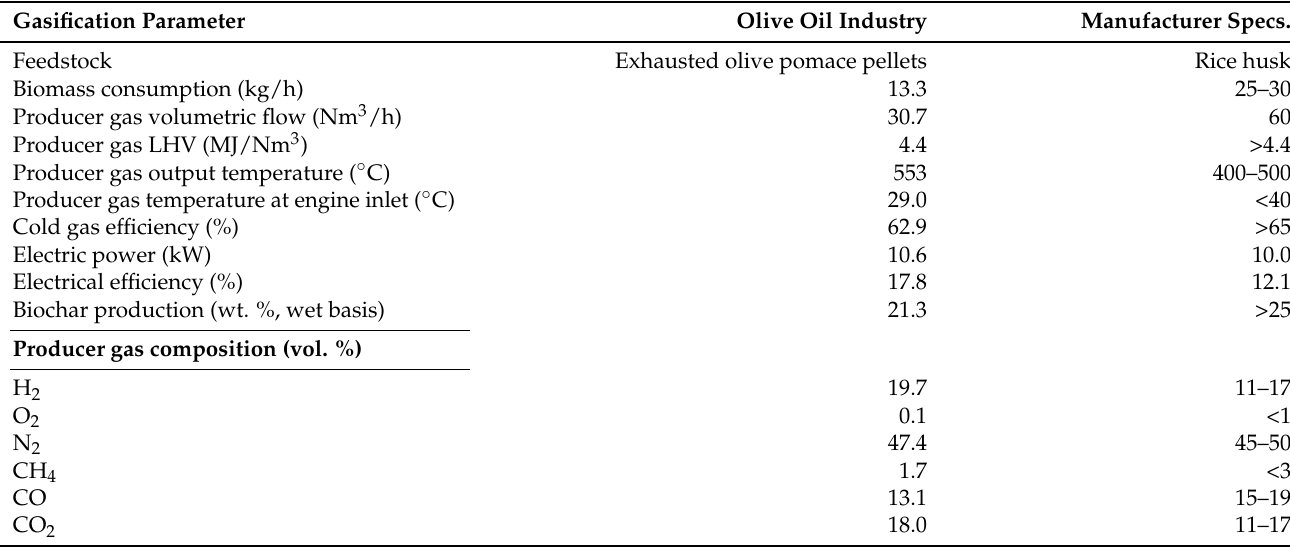
Figure 5. Electrical parameters measured at the output of the engine–generator set. Table 7. Gasification performance parameters with residues from the olive industry and manufacturer specifications for rice